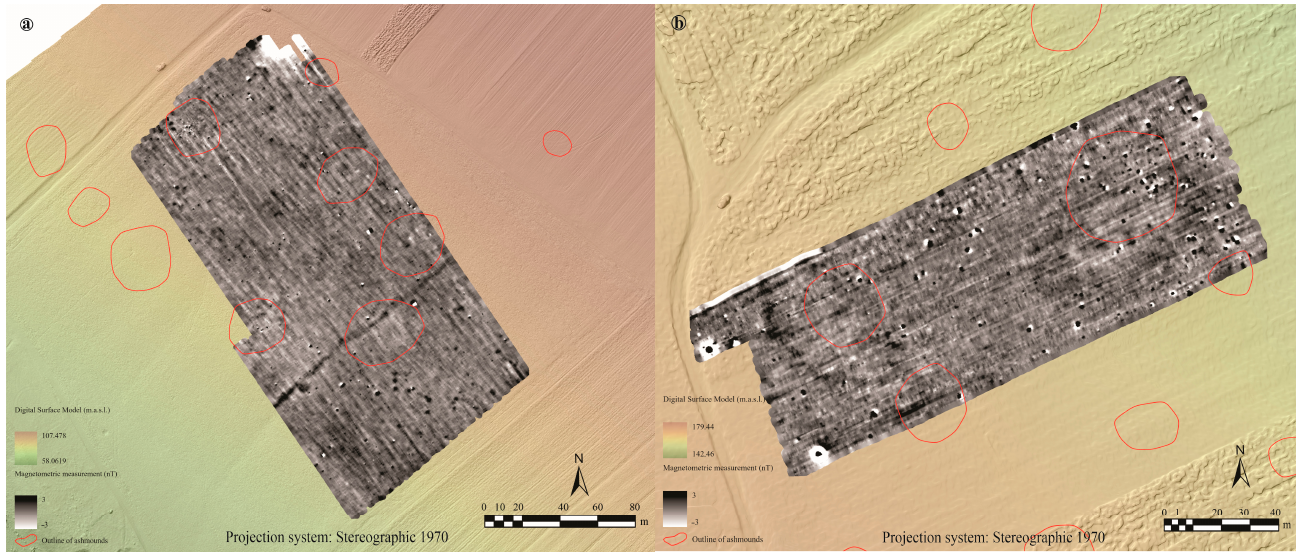
Figure 13. Results of magnetometer measurements for the settlements from ( a ) Coarnele Caprei– Aramei Hill I (Ia ș i County); ( b ) B ă deni– Moara de Vânt Hill (Ia ș i County).